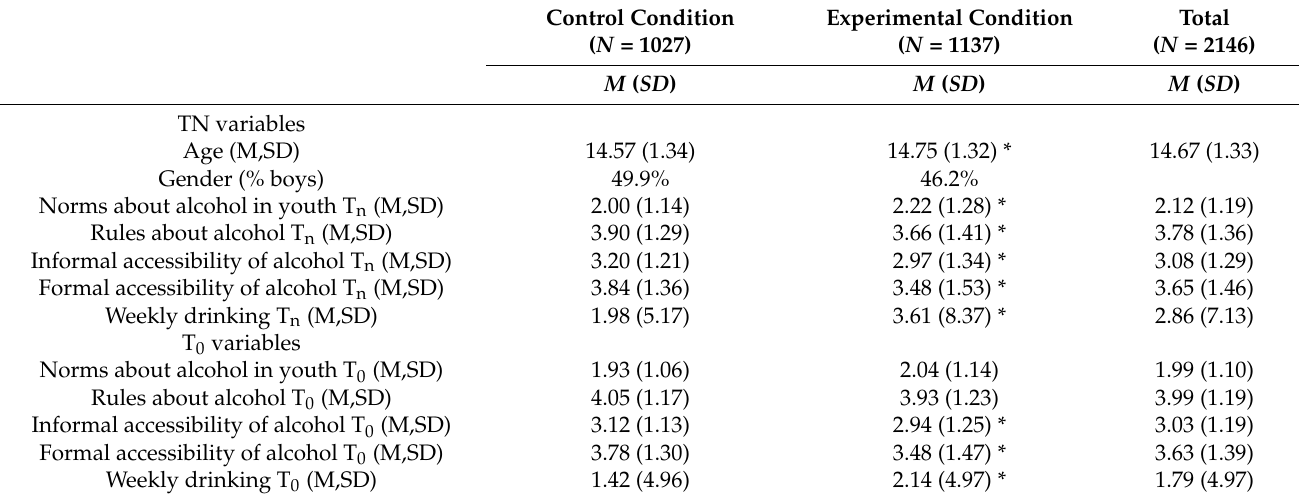
Table 1. Descriptive Data on all Variables of Interest for the Control and Experimental Condition and Total Sample. Control